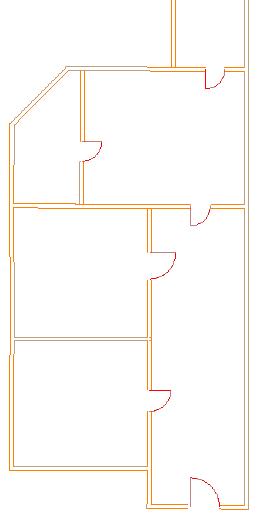
Figure 2. Sample CAD floorplan input